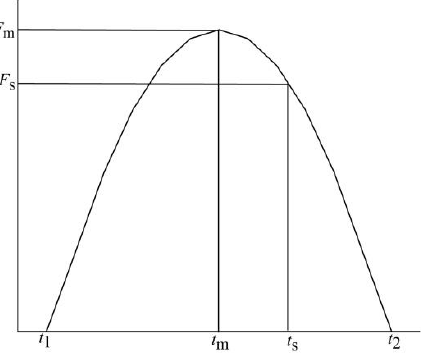
Figure 2. Variation curve of collision impact force-time for oil sunflower plug seedlings. t 1 is the start loading times; t m is the times corresponding to the maximum collision impact force; t s is the time corresponding to the maximum compression; t 2 is the collision end times; F m is the maximum collision impact force; F s is the collision impact force corresponding to the maximum compression.